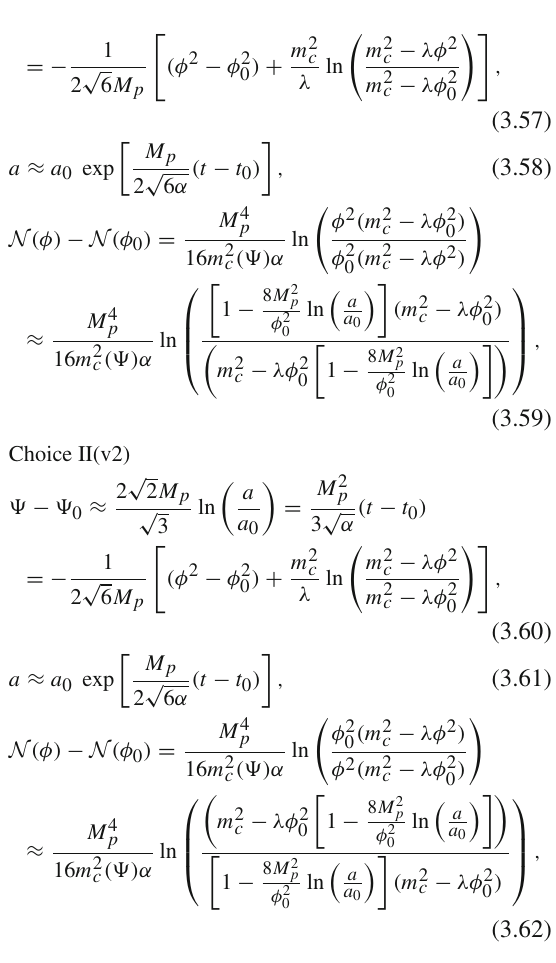
(cid:15) | m | , b Choice 2 c | λ |